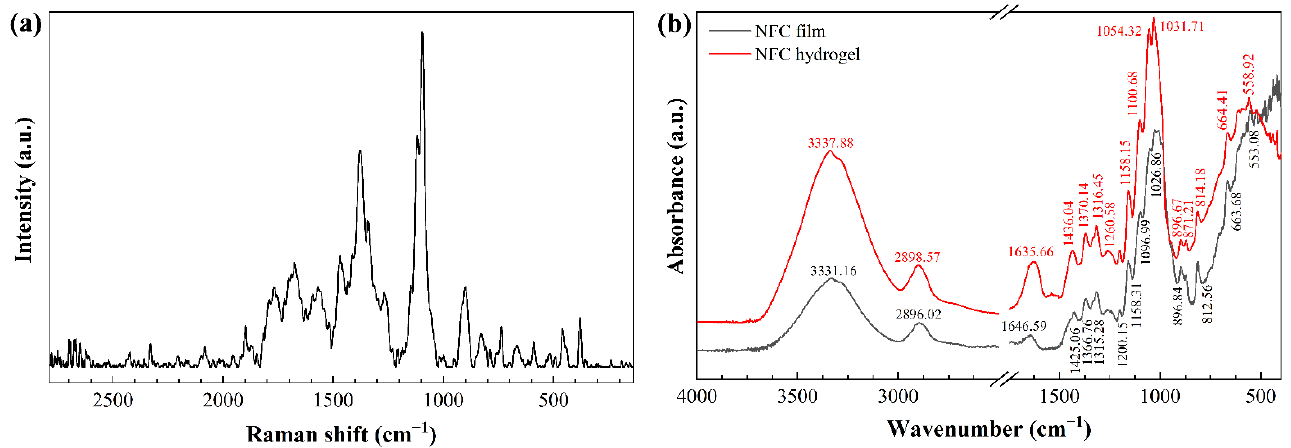
Figure 4. ( a ) Raman and ( b ) FTIR spectra of ivory nut nanocellulose